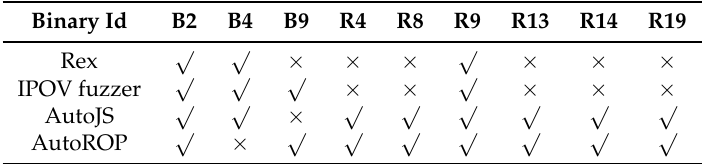
Table 4. The list of binary files that can be exploited by different vulnerability discovery methods. √ The symbols “ ” and “ × ” represent whether a binary file can be exploited by a specific method or not,